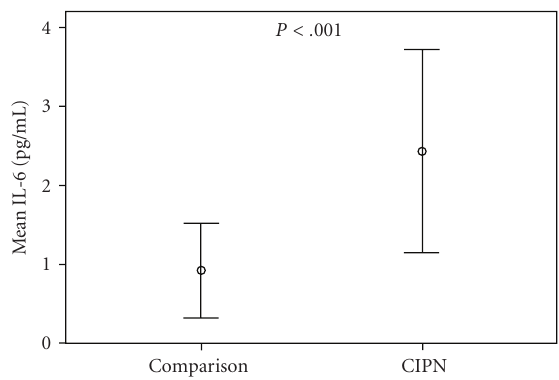
Figure 1: Mean levels of serum interleukin [IL]-6 in women with painful CIPN ( N = 20) and women without CIPN symptoms (Comparison Group, N = 20). Dots represent mean value of Interleukin [IL]-6 measured in serum; error bars represent 95% CI. Mean (SD), [Range] of the painful CIPN group: 2.43 (1.7)pg/mL [1 . 3–3 . 8]; Comparison group: 0.92 (0.6)pg/mL [0 . 4–1 . 5]. Inde- pendent t -test with Bonferroni correction performed to examine di ff erence between groups: ( t (38) = − 5.6, P < . 001).